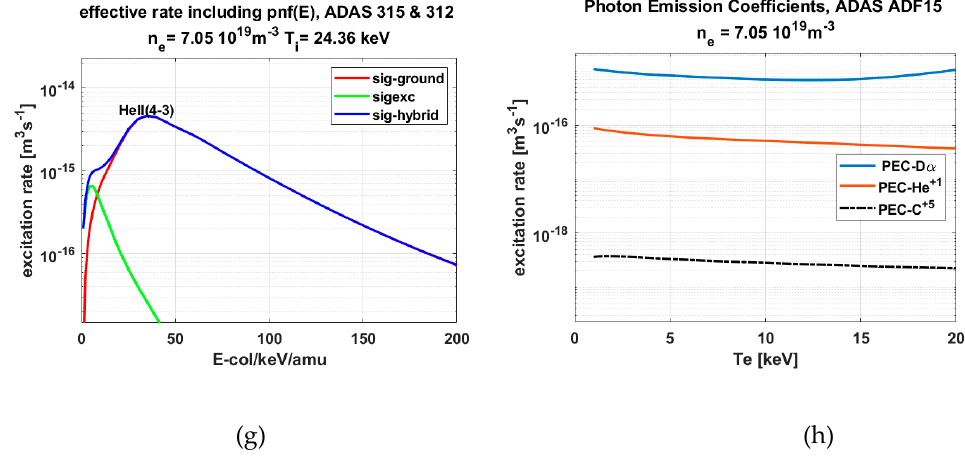
Figure 2. ( a ) Effective neutral beam beam emission spectroscopy (BES) D α emission rate versus collisional energy, ADAS file ADF312(2003); ( b ) excited n = 2 population of injected neutral beam versus collisional energy, ADAS file ADF312(2003); ( c ) DI(3-2)-CX effective emission rate from ground (1s) and excited (n = 2) states, AFD315(1997); ( d ) NeX(10-9)-CX Effective emission rate from ground (1s) and excited (n = 2) states; ( e ) CVI(8-7)-CX Effective emission rate from ground (1s) and excited (n=2 )states; ( f ) BeIV(6-5)-CX effective emission rate from ground (1s) and excited (n = 2) states; ( g ) HeII(4-3)-CX Effective emission rate from ground (1s) and excited (n = 2 )states. The ADAS data base covers collisional rates up to 500 keV/am, see section on Fast Ion CXRS; ( h ) Photon emission coefficients for electron collisional excitation. PEC rates for HeII are about 250 times higher than those for CVI . 7.05x 10 19 for